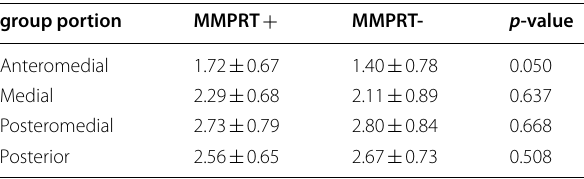
Table 2 Medial meniscus degeneration grade (average according to Jerosch et al. 17) at 4